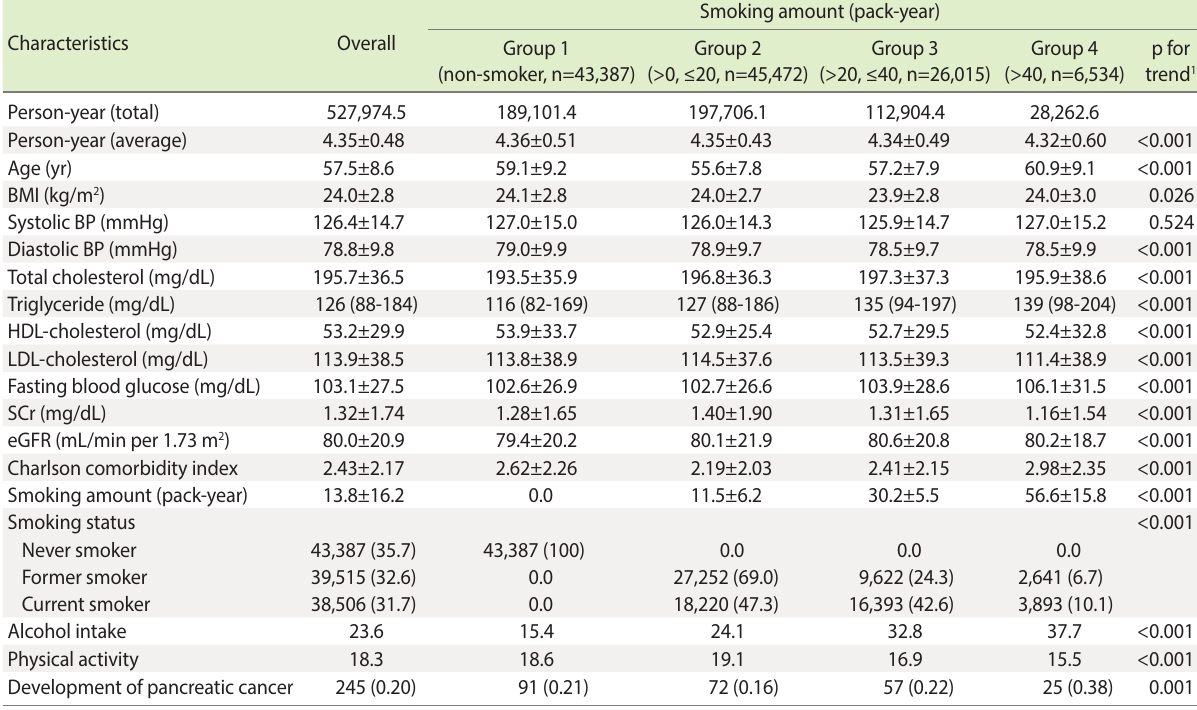
Table 1. Baseline characteristics of men participants according to 4 smoking amount groups (n=121,408)